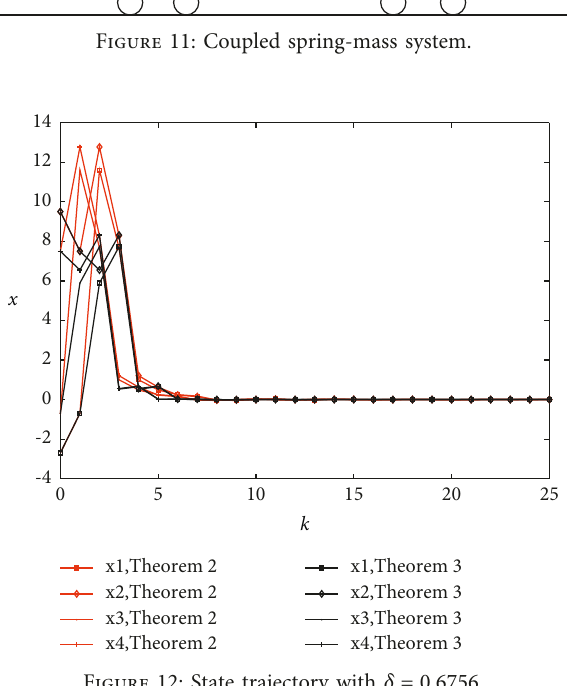
Figure 12: State trajectory with δ � 0 . 6756.